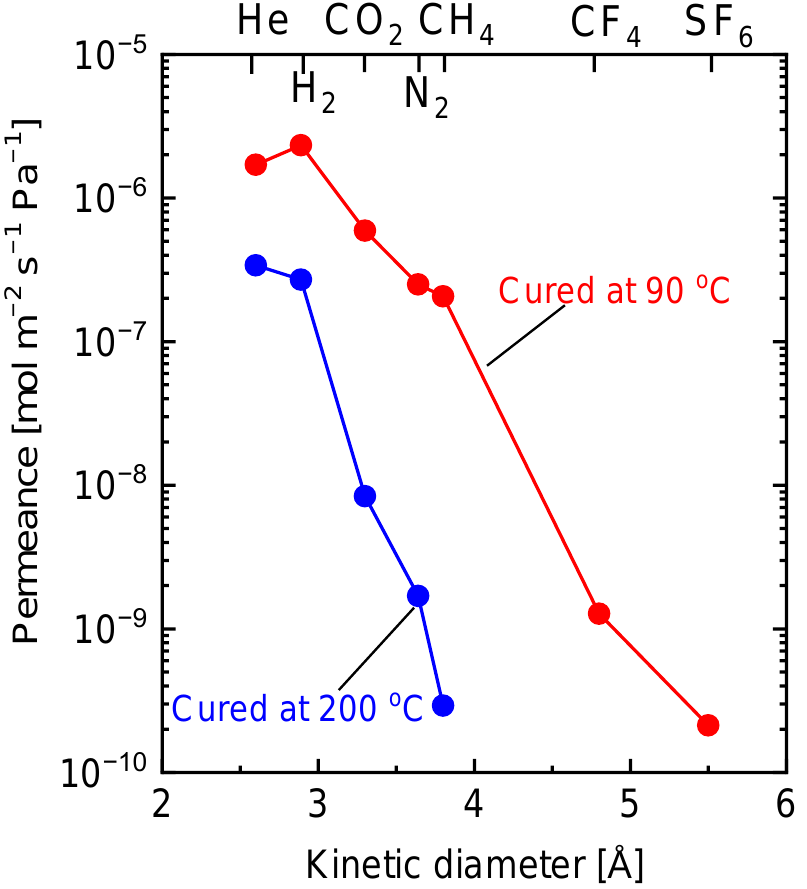
Figure 24. Single-gas permeance at 300 °C as a function of kinetic diameter for carbon-SiO 2 -ZrO 2 membranes prepared from SiO 2 -ZrO 2 -polybenzoxazine resins cured at 90 and 200 °C. Adapted from [110,111].